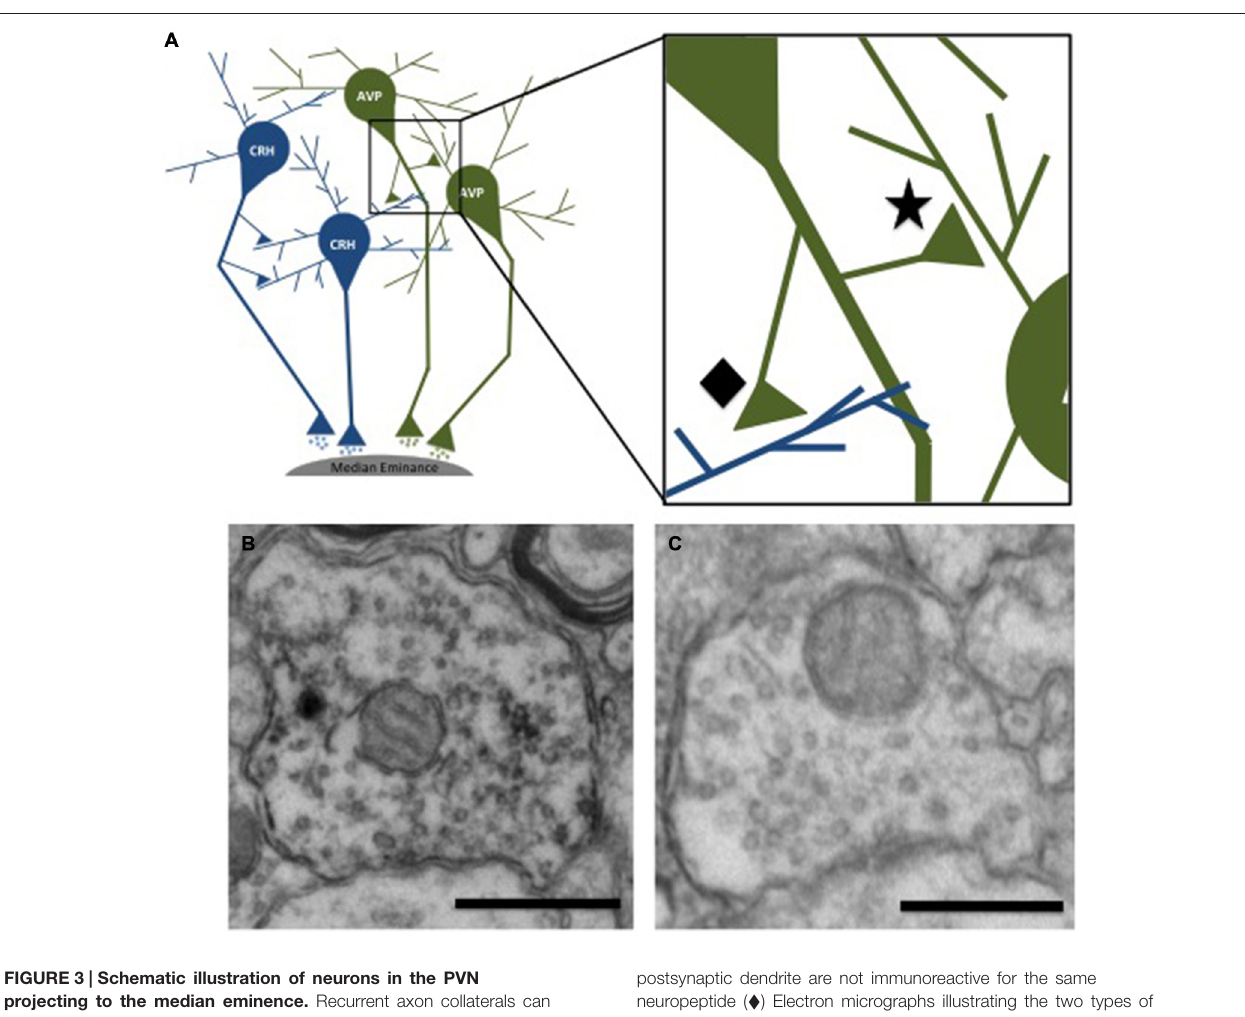
FIGURE 3 | Schematic illustration of neurons in the PVN projecting to the median eminence. Recurrent axon collaterals can be seen contacting neighboring parvocellular neurons. (A) The inset shows recurrent terminals in which both the nerve terminal and postsynaptic dendrite are immunoreactive for the same peptide ( (cid:70) ) and non-recurrent synaptic contacts where the nerve terminal and